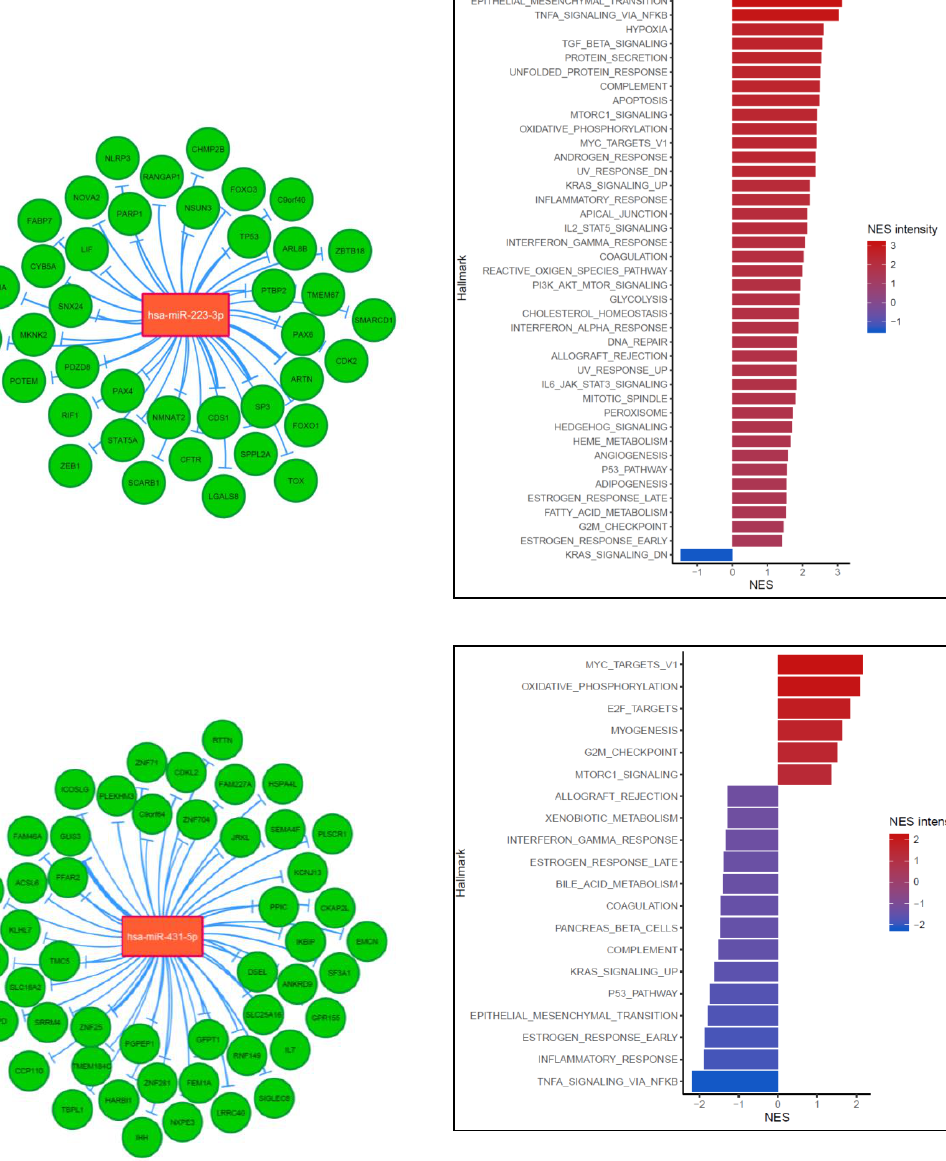
Figure 4. mir-223 and mir-431 regulates several cancer and inflammatory pathways in RMS. ( A ) The figure illustrates an interaction network consisting of our miR-223 (in orange) and their down-modulated target genes (in green) obtained through miRNet in RMS cohort. GSEA graphs show the modulation of several pathways according to miR-223 expression in tumor tissues. ( B ) The figure shows an interaction network consisting of target genes down-modulated (in green) by miR-431(in orange) and their obtained through miRNet. MiR-431 levels modulated several pathways according to GSEA analysis. For both integrated analyses, the size of links between genes and miRNAs di ff ers according to their correlation value: the thicker the link, the more negative is the correlation between the corresponding couple miRNA-gene (that is the more they are anti-correlated).